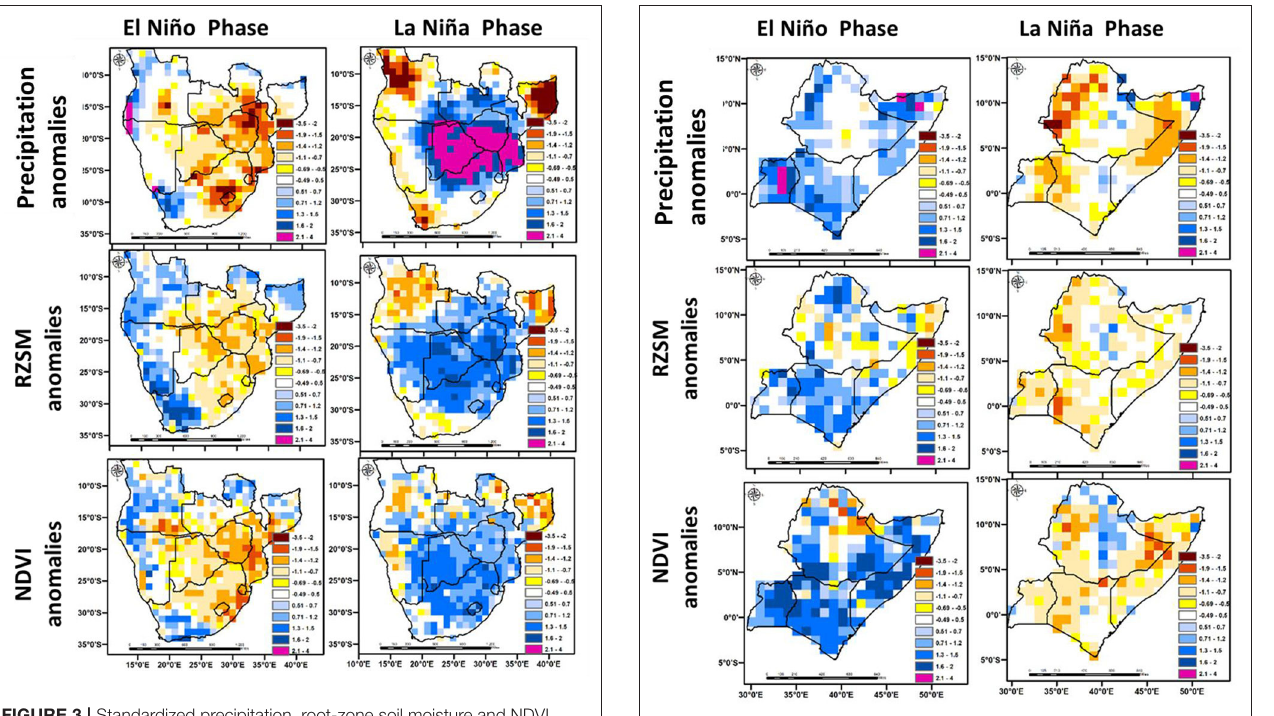
scale compared to the soil moisture and NDVI anomalies.